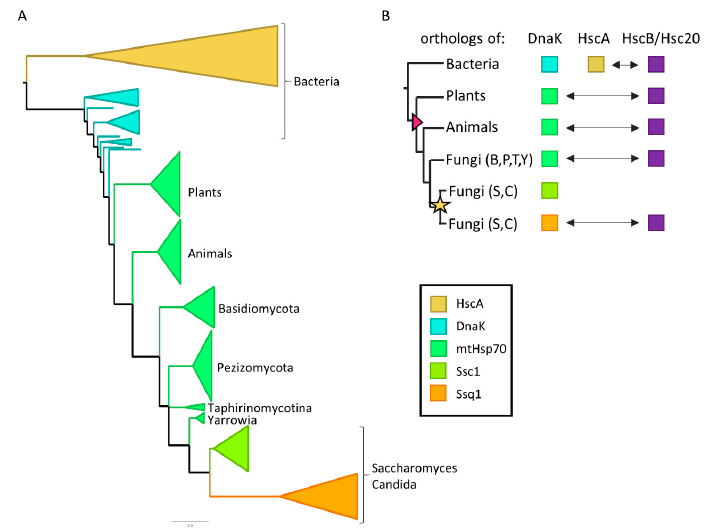
Figure 1. Evolutionary relationships among Hsp70 systems involved in the FeS biogenesis in bacteria and mitochondria. ( A ) Maximum likelihood phylogeny of Hsp70s involved in the FeS biogenesis. Scale bar: amino acid substitutions per site. Only nodes with bootstrap support > 0.7 are resolved. The tree was rooted at the HscA and DnaK common ancestor for the clarity only. For fully resolved tree see Supplementary Figure S1. ( B ) Evolutionary history of Hsp70 systems involved in the FeS biogenesis. In bacteria specialized Hsp70 HscA functions in FeS biogenesis with dedicated JDP HscB, while multifunctional Hsp70 DnaK plays other biological roles. At the base of the Eukaryote lineage (pink triangle) HscA was lost. Cooperating with ortholog of HscB termed Hsc20, mtHsp70, a descendant of DnaK, replaced it in mitochondrial FeS biogenesis. At the base of the Saccharomyces and Candida clade (S,C), duplication of the mtHsp70 gene (yellow star) resulted in formation of Ssq1, which subsequently became specialized in FeS biogenesis, recapitulating specialized HscA / HscB bacterial system. Arrows indicate functional interactions between orthologs of HscB / Hsc20 and their Hsp70 partners. Fungi: Basidiomycota (B), Pezizomycotina (P), Taphrinomycotina (T), Yarrowia (Y), Saccharomyces (S), Candida